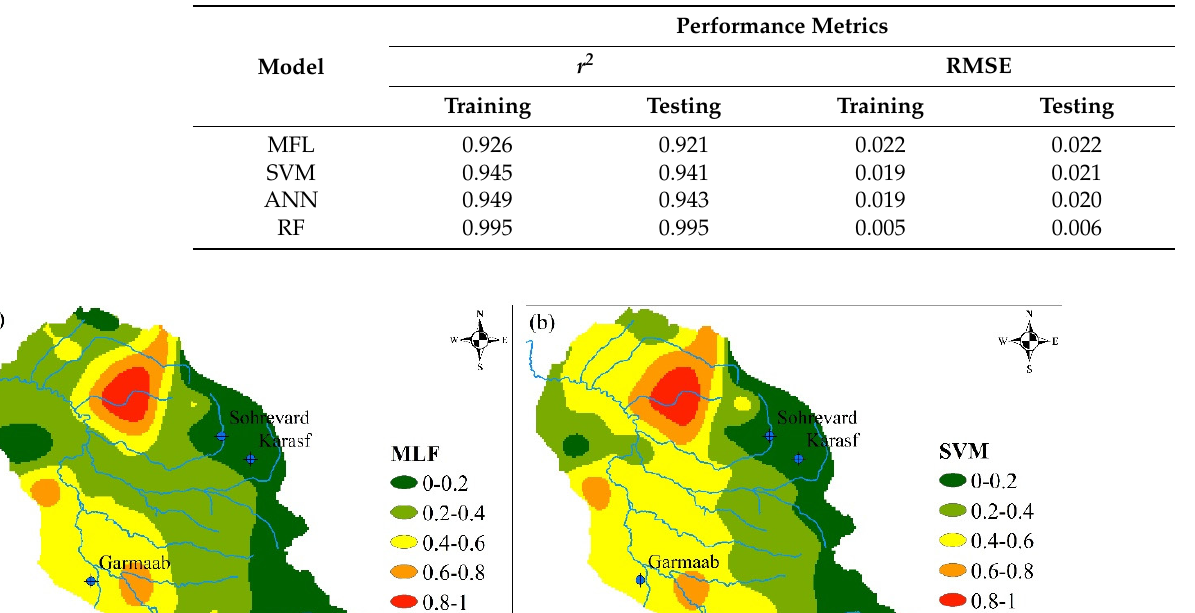
Table 4. Performance metrics for AI models.